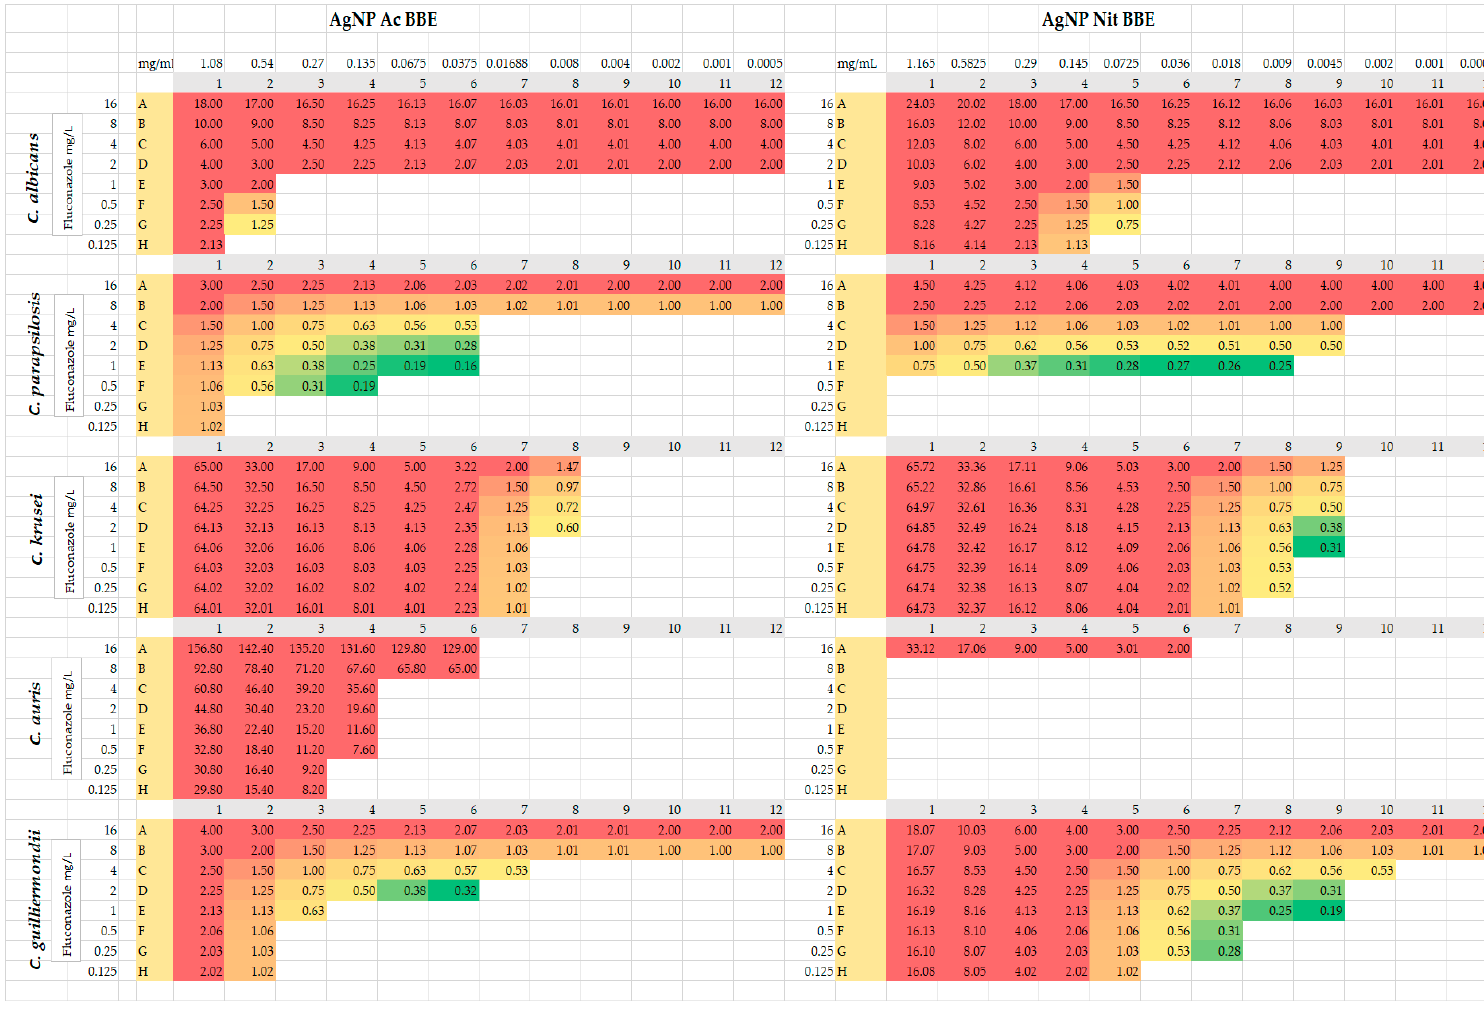
Figure 2. Checkerboard method—FIC results from synergy tests for AgNP BBEs in combination with fluconazole. The results highlighted in green ( ≤ 0.5) were considered synergistic, results highlighted in yellow (0.5–2) were considered indifferent, and results highlighted in red (>2) were considered antagonistic.